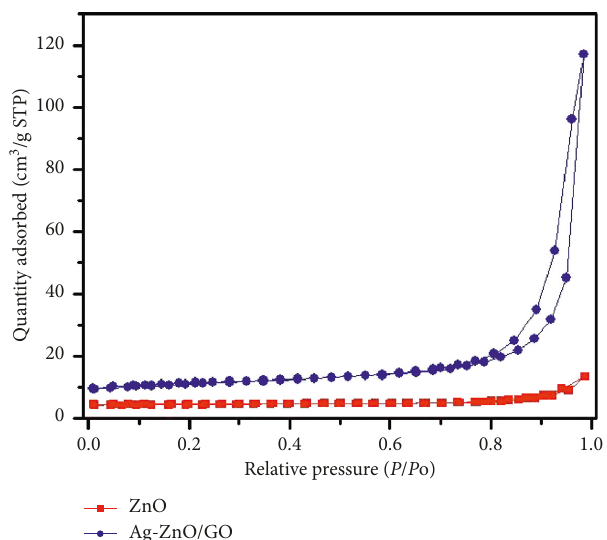
Figure 6: BET analysis data of synthesized materials.